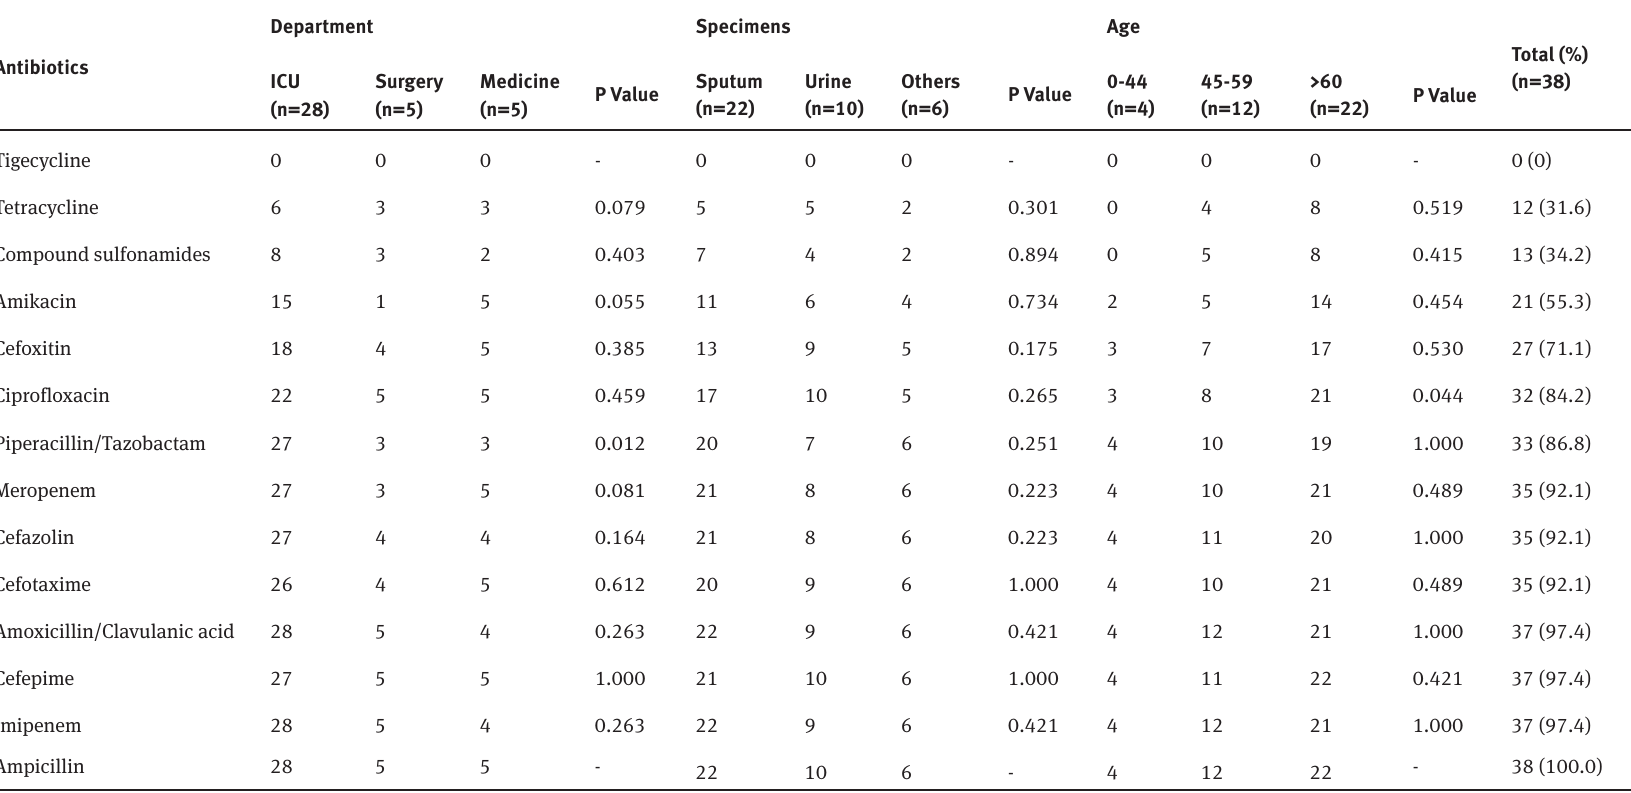
Table 1: Antimicrobial resistance of 38 carbapenem-resistant Klebsiella pneumoniaee (CRKP) strains